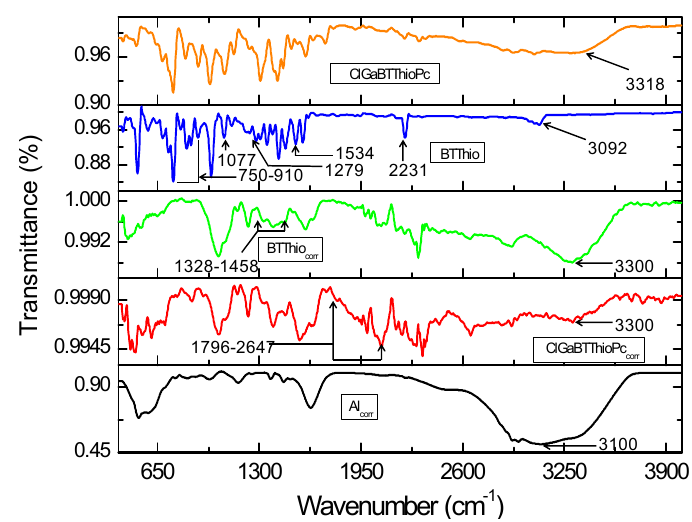
Figure 8. Infrared spectra of corroded aluminum in the absence of inhibitor (Al corr ), corroded aluminum in the presence of inhibitors (BTThio corr and ClGaBTThioPc corr ), and the inhibitors (BTThio and ClGaBTThioPc).